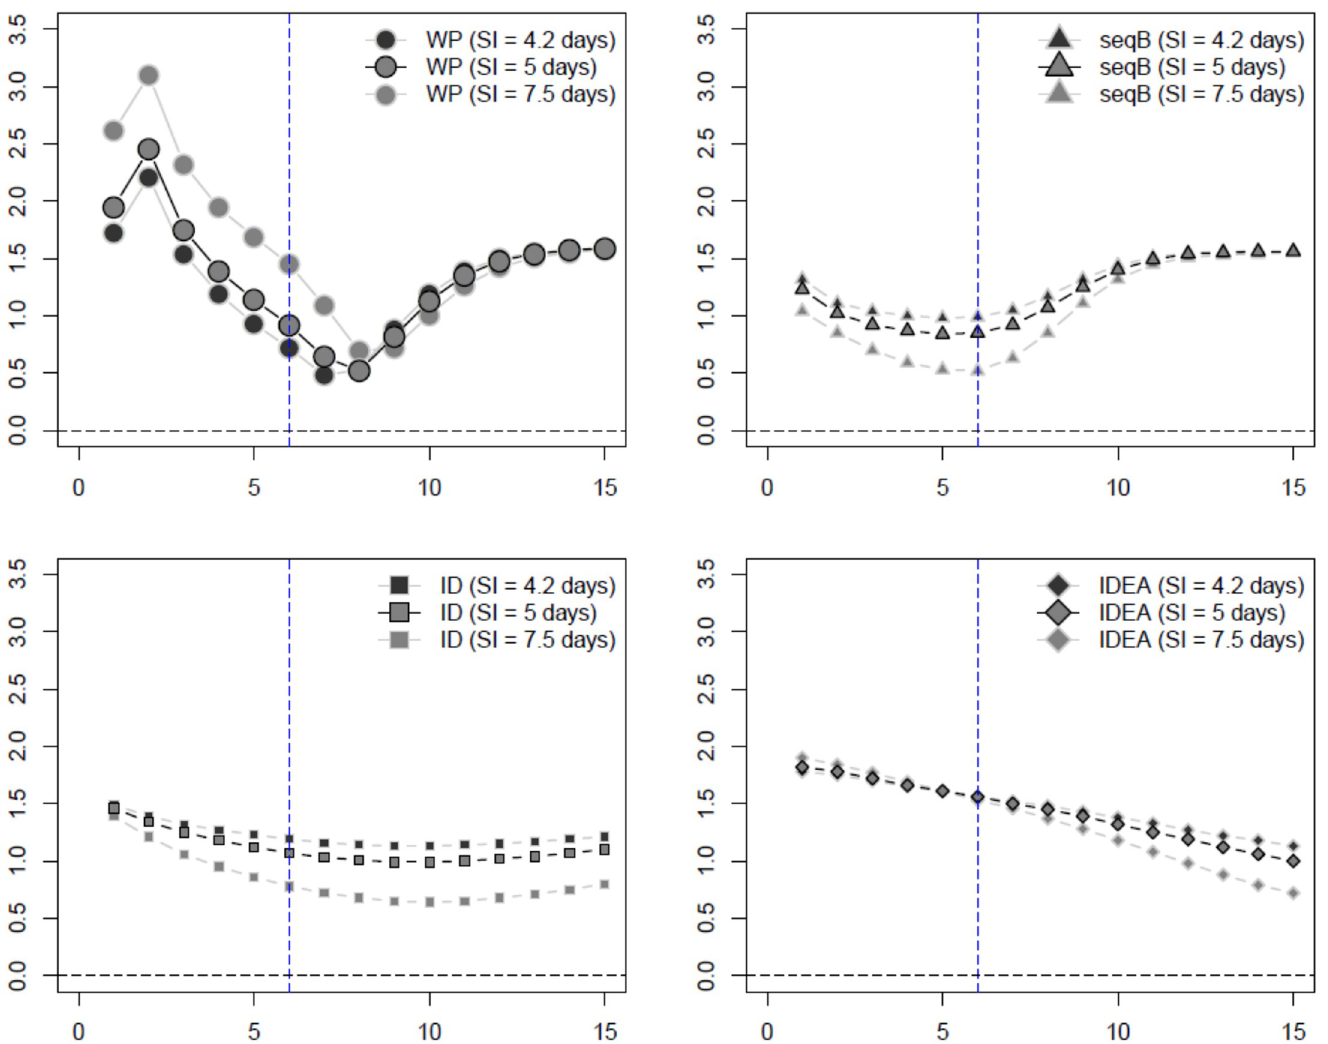
Fig 4. COVID-19 estimated MSE of R 0 estimators assuming known serial interval (SI) with SEAIR data (week on x -axis). The inflection point indicated by the blue dashed vertical line.